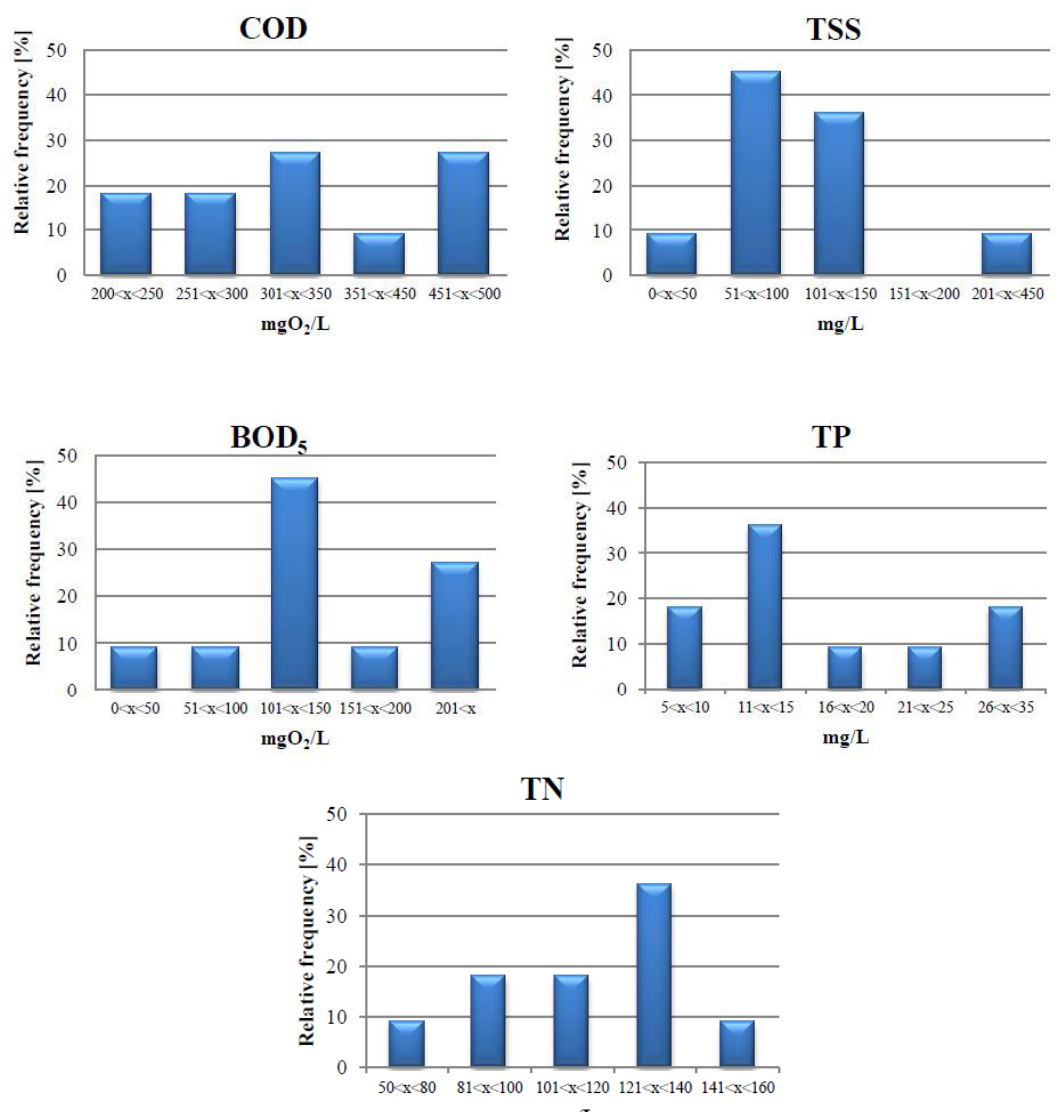
Figure 2. Frequency histograms for pollution parameters (BOD 5 , COD, TSS, TN and TP) in the influent to the constructed wetland.